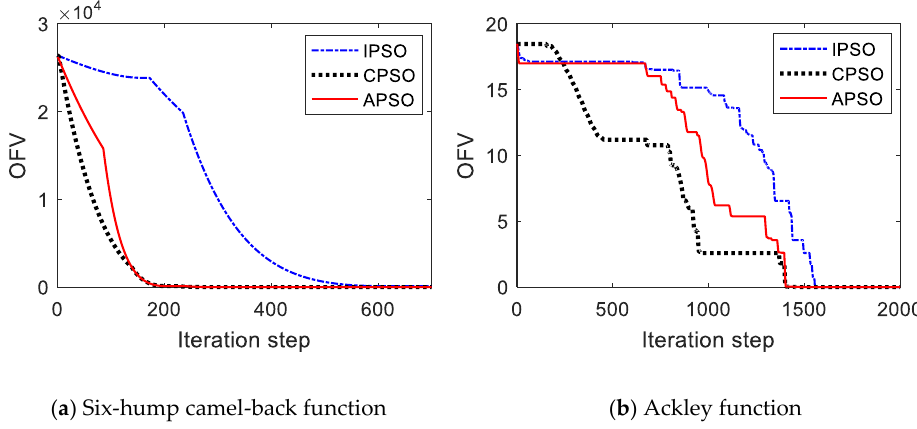
Figure 5. Objective function value (OFV) variation process of two benchmark functions. Table 3. Function calls comparison.